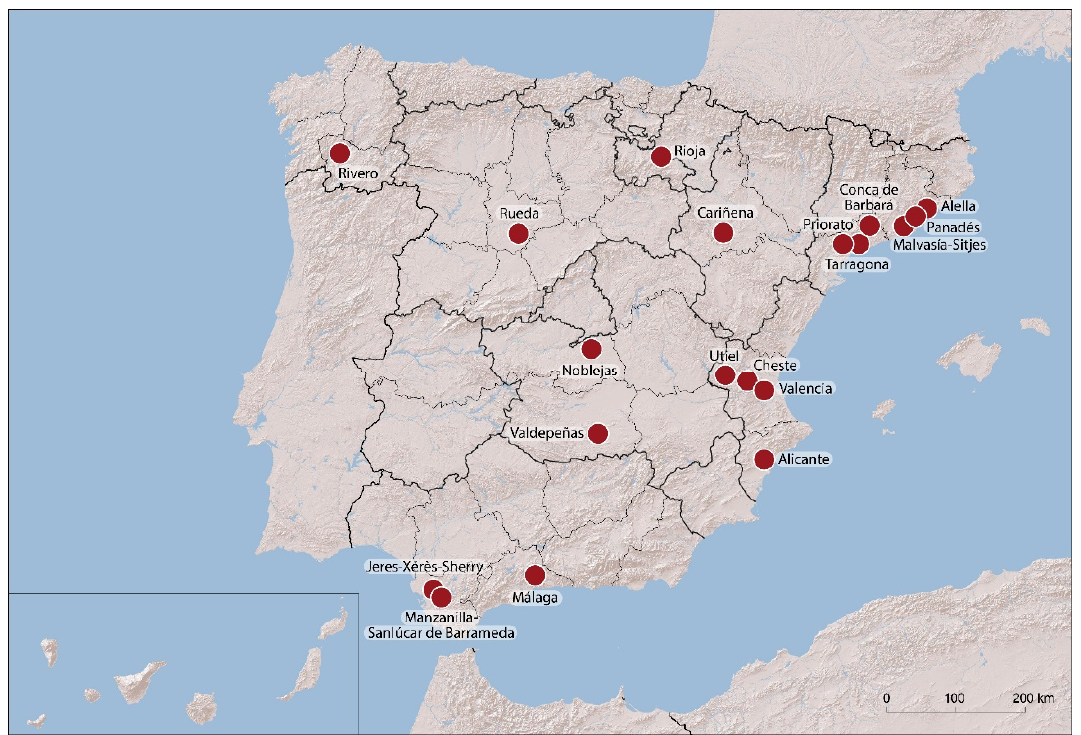
Figure 7. Wines included in the 1932 Wine Statute for protection under the term designations of origin. Source: Wine statute of 1932. Own elaboration. NB: The spelling of the DO is transcribed as they appear in the Statute.